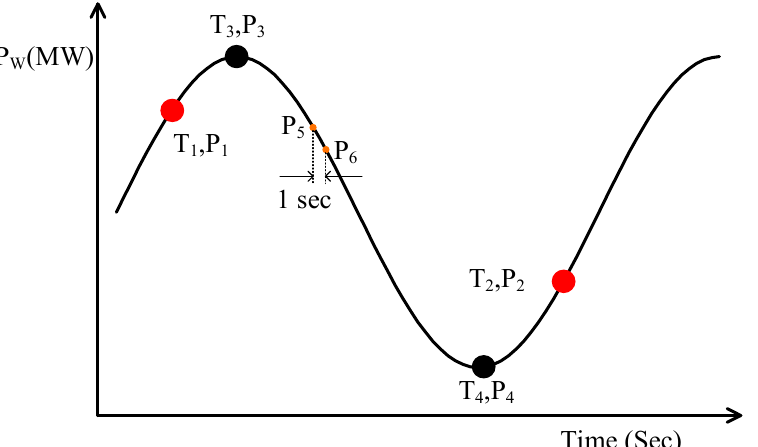
Figure 1. Ramp-rate calculation techniques: (i) RR = (P2 − P1)/(T2 − T1), where T2 − T1 = 1 min; (ii) RR = (P4 − P3)/(T4 − T3); (iii) RR = (P6 − P5)/1 s.